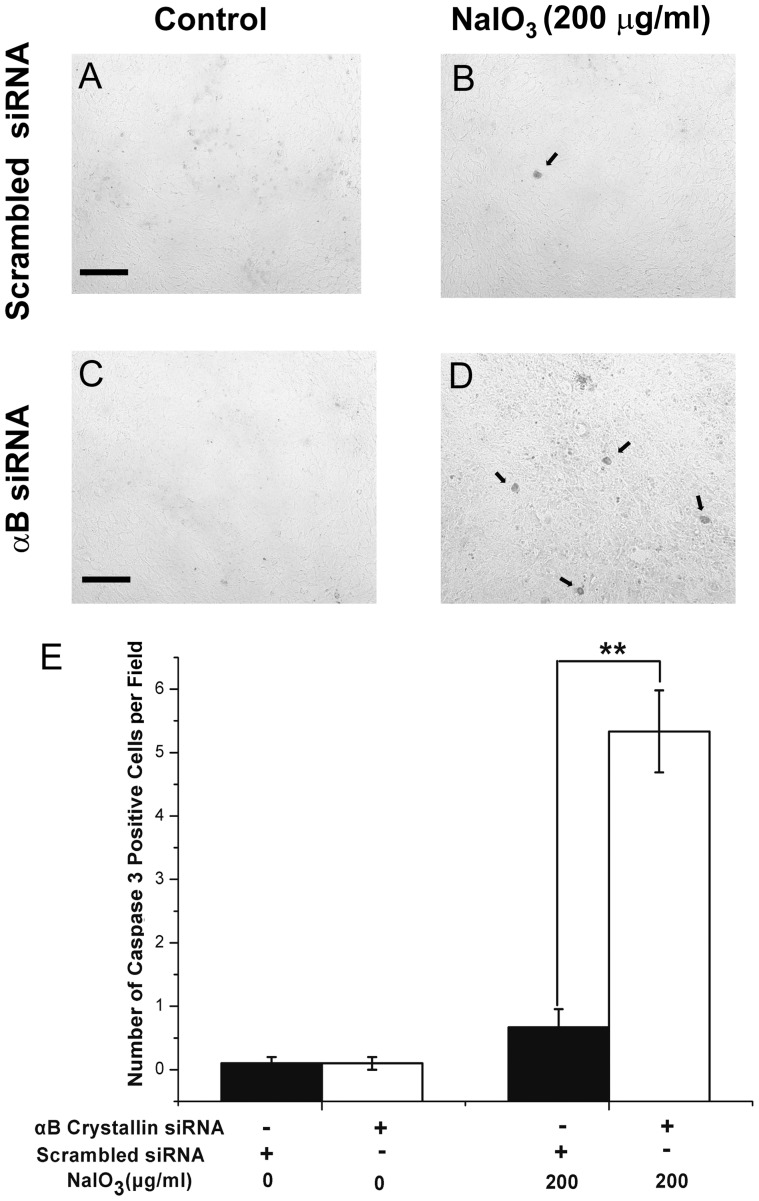
Caspase 3 activation with NaIO3 treatment and increased activation with knockdown of αB crystallin siRNA in human RPE cells.Forty-eight hours after scrambled siRNA or αB crystallin siRNA transfection, human RPE cells were treated with 200 µg/ml NaIO3 for 24 hours. Cleaved caspase 3 staining was performed in scrambled siRNA-transfected human RPE cells (A, B) and αB crystallin siRNA-transfected human RPE cells (C, D). Treatment with 200 µg/ml of NaIO3 resulted in increased amount of cleaved caspase 3-positive cells with αB crystallin siRNA-transfection vs. scrambled siRNA controls (E). Data are mean ± SEM from three individual experiments, αB siRNA refers to αB crystallin siRNA in panels C and D. **P<0.01. Scale bar = 40 µm.